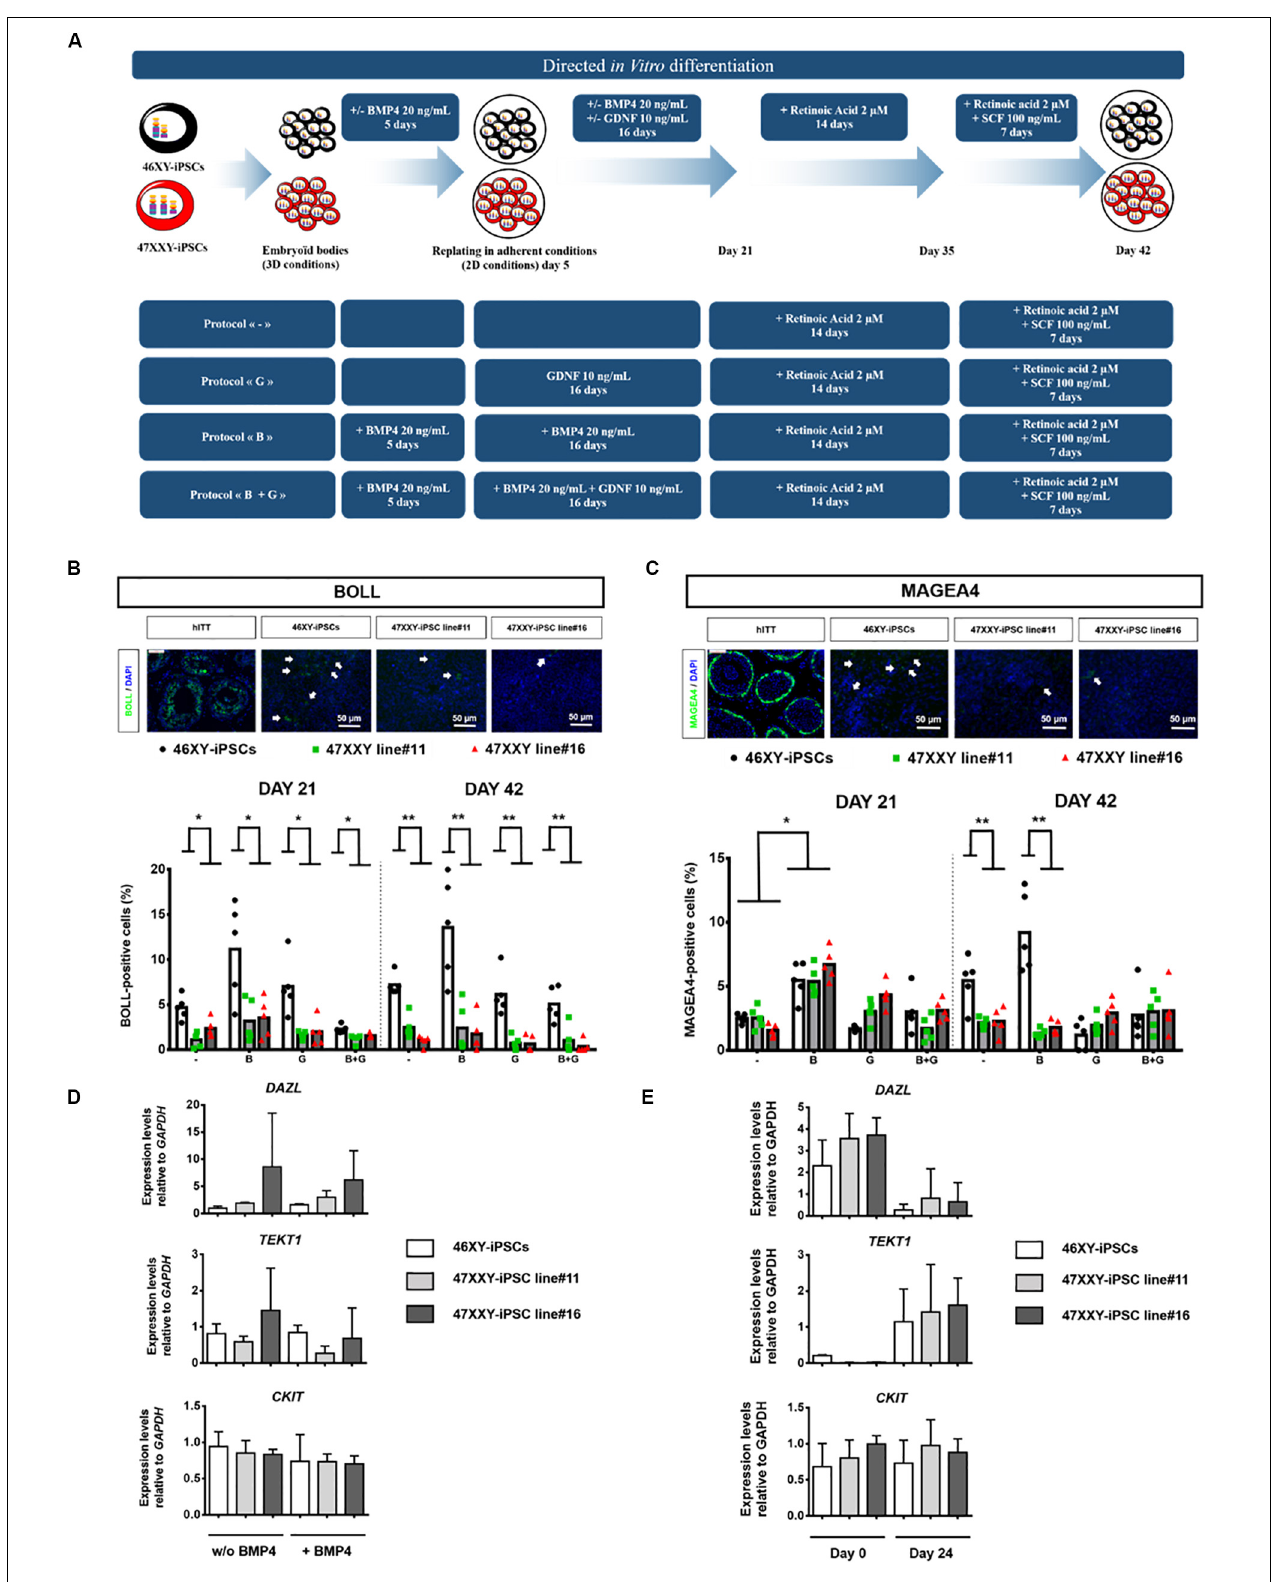
FIGURE 3 | Directed in vitro differentiation of 46XX-iPSCs and 47XXY-iPSCs into germ cell lineage. (A) Schematic representation of the 4 different protocols used for iPSC differentiation into germ cell lineage. These protocols differed only in the first steps of the differentiation; with or without 20 ng/mL BMP4 in the 5 first days of